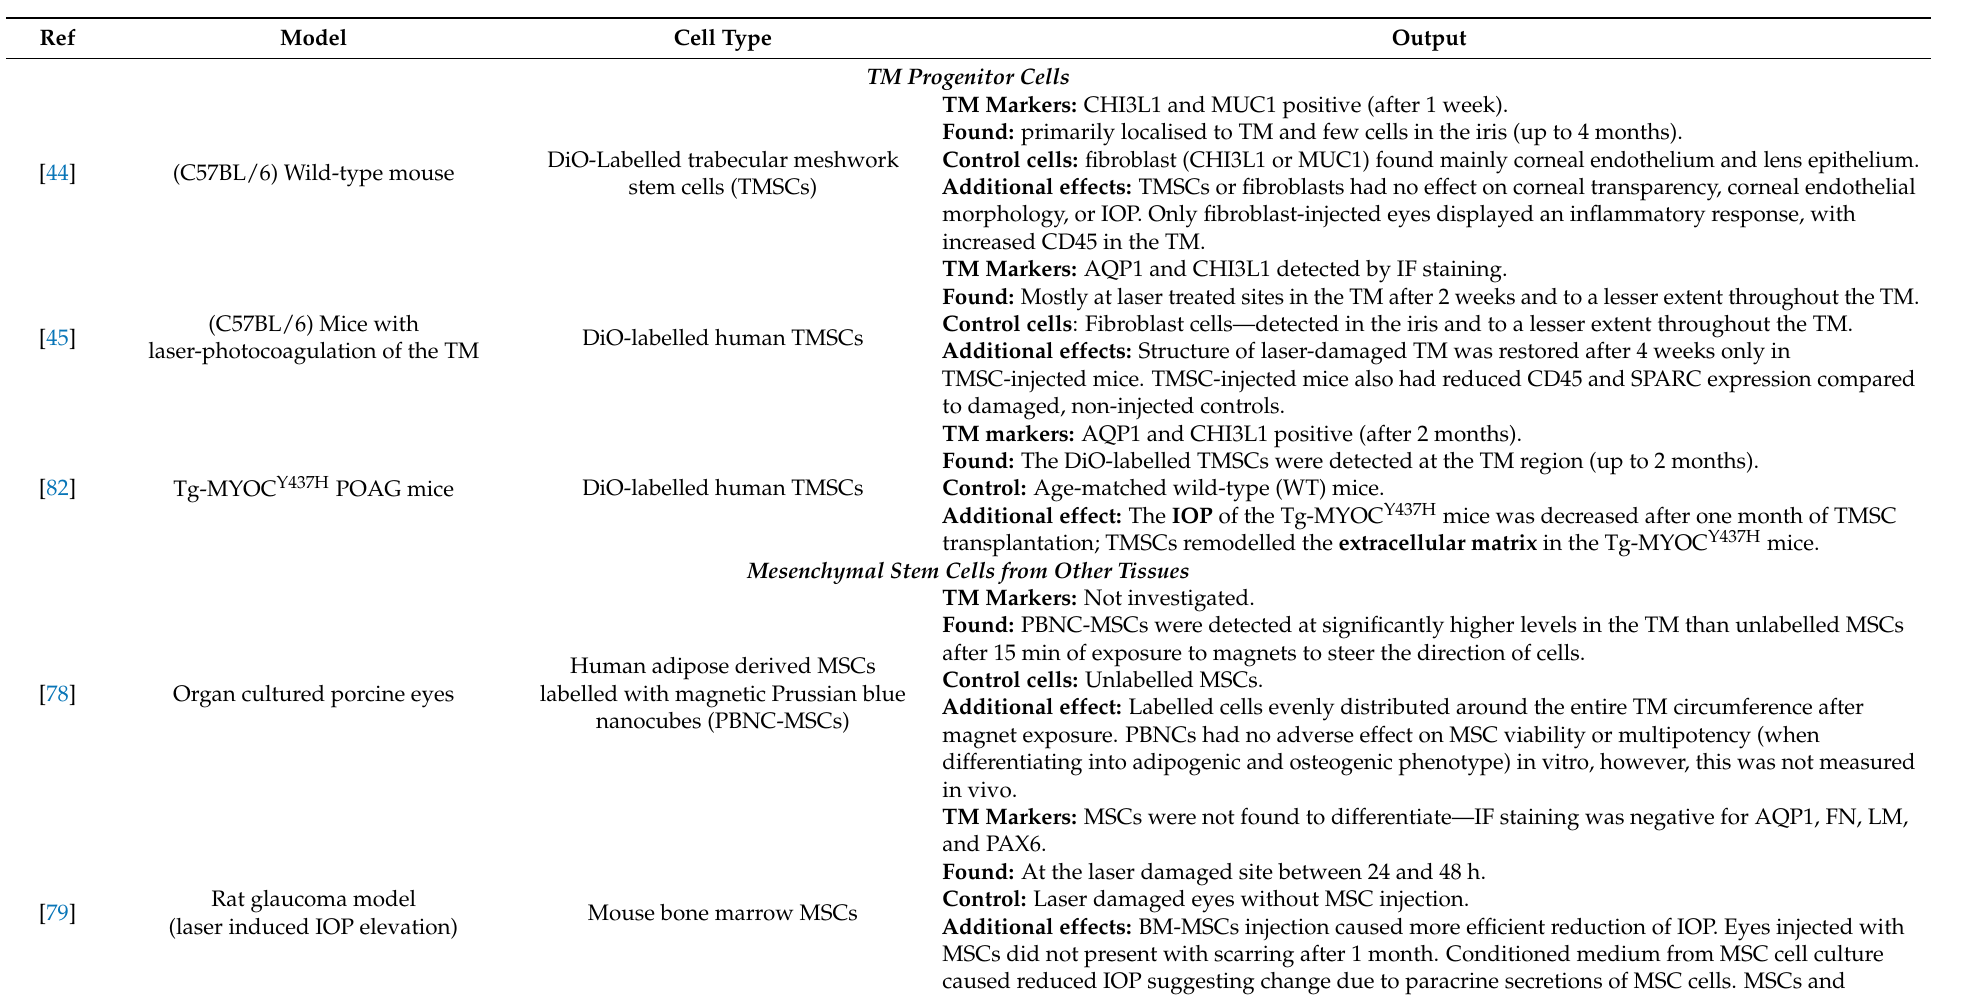
Table 5. A summary of studies to date that transplanted iPSC, MSC, or TM progenitor cells into animal and organ culture models. Outputs are summarised to reflect the characterisation of cells in situ following transplant, their location, inflammation in comparison to control cells, and their effect on IOP. IF-immunofluorescent